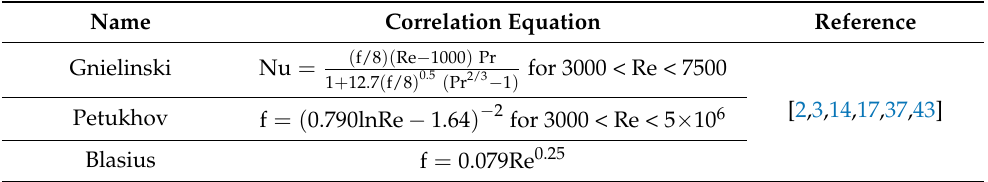
Figure 4. ( a )Verification of Nusselt number for empty channel of solar air heater. ( b ) Verification of friction factor for empty channel of solar air heater. Table 7. Correlation equations for the verification of the empty channel